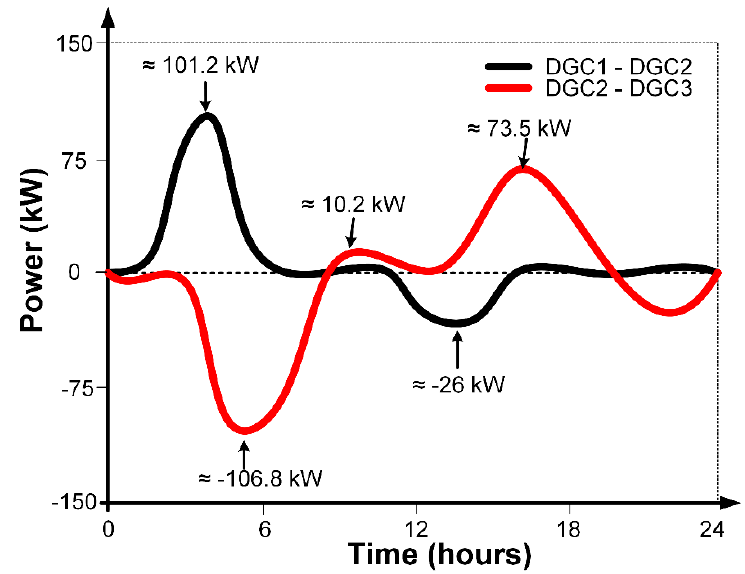
Figure 8. Particular analysis of energy exchange process between the DGCs considering smooth filtering (curve smoothing) every 10 min.